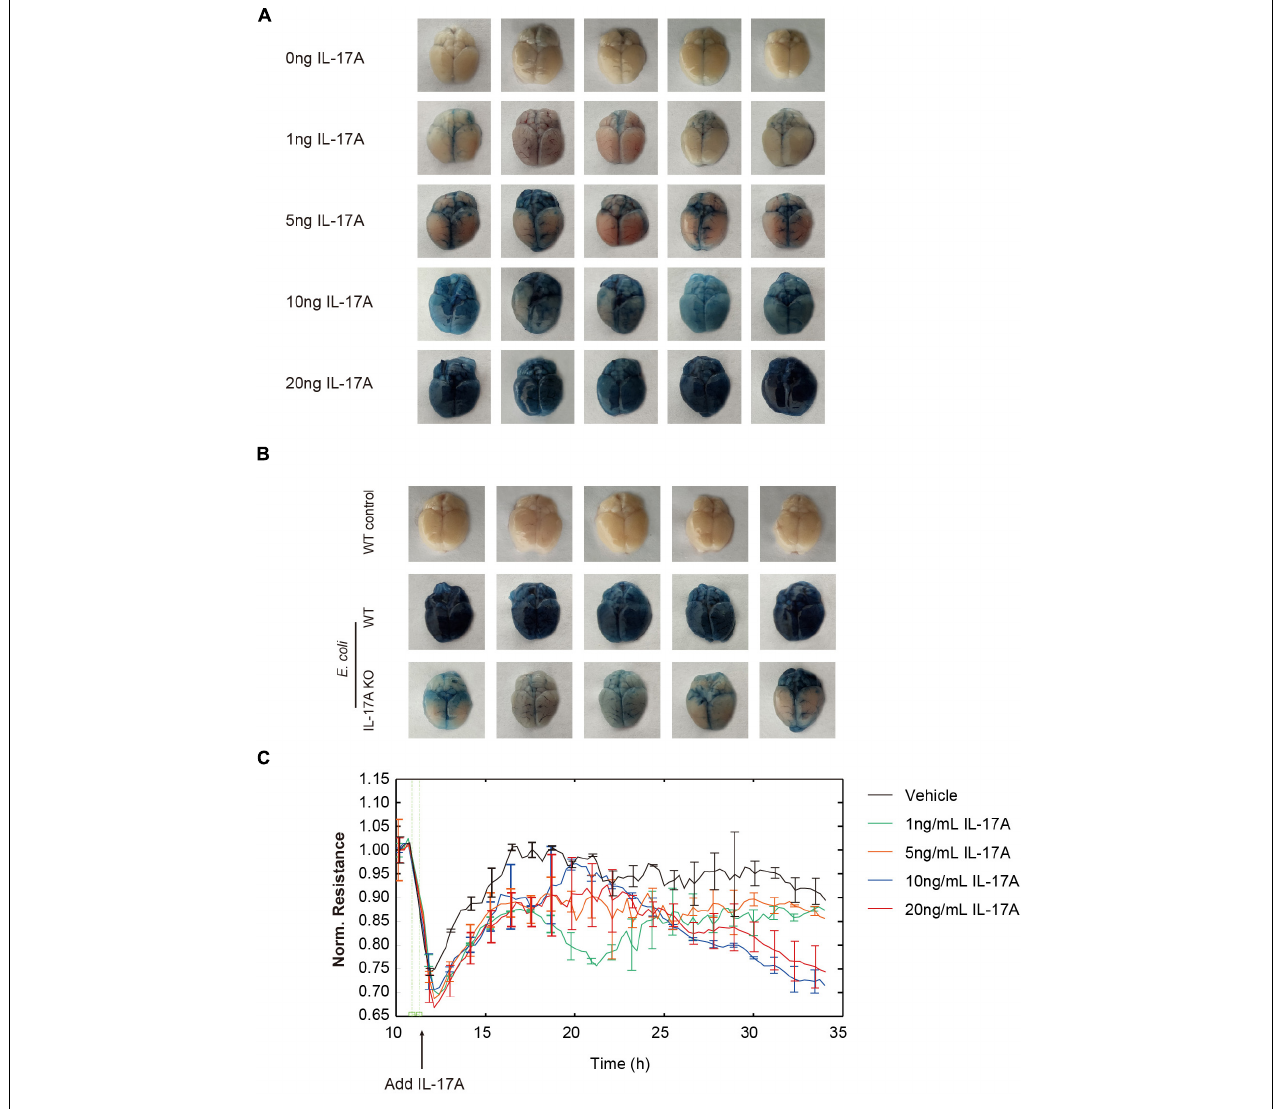
FIGURE 2 | Interleukin-17A contributes to the increase of BBB permeability. (A) Effects of the recombinant mouse IL-17A (0, 1, 5, 10, and 20 ng/mouse) on the permeability of the mice brain evaluated by Evan’s blue approach. (B) The permeability of control mice, E. coli challenged WT or IL-17A KO mice evaluated by Evan’s blue approach. (C) TEER changes of hBMECs in the treatment of multiple dosage of IL-17A monitored by the ECIS system. Data were collected and presented as mean ± SD from three replicated wells at each time